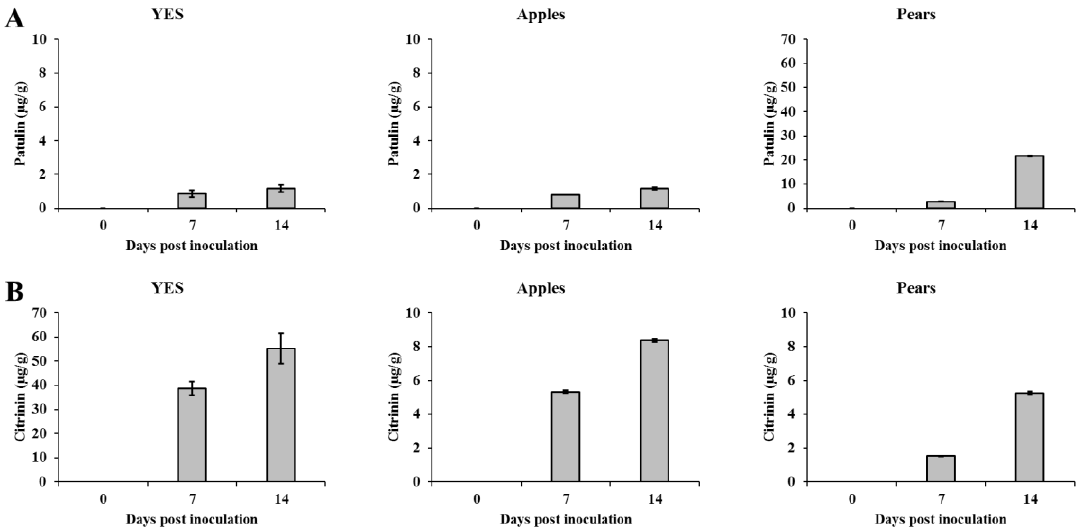
Figure 1. PAT ( A ) and CTN ( B ) production by P. expansum Pe-21 strain after 7 and 14 days of growth on YES medium, apples, and pears. Average values of three replicates ( ± standard error) are reported. Experiments were repeated three times and results of a single representative experiment are shown.